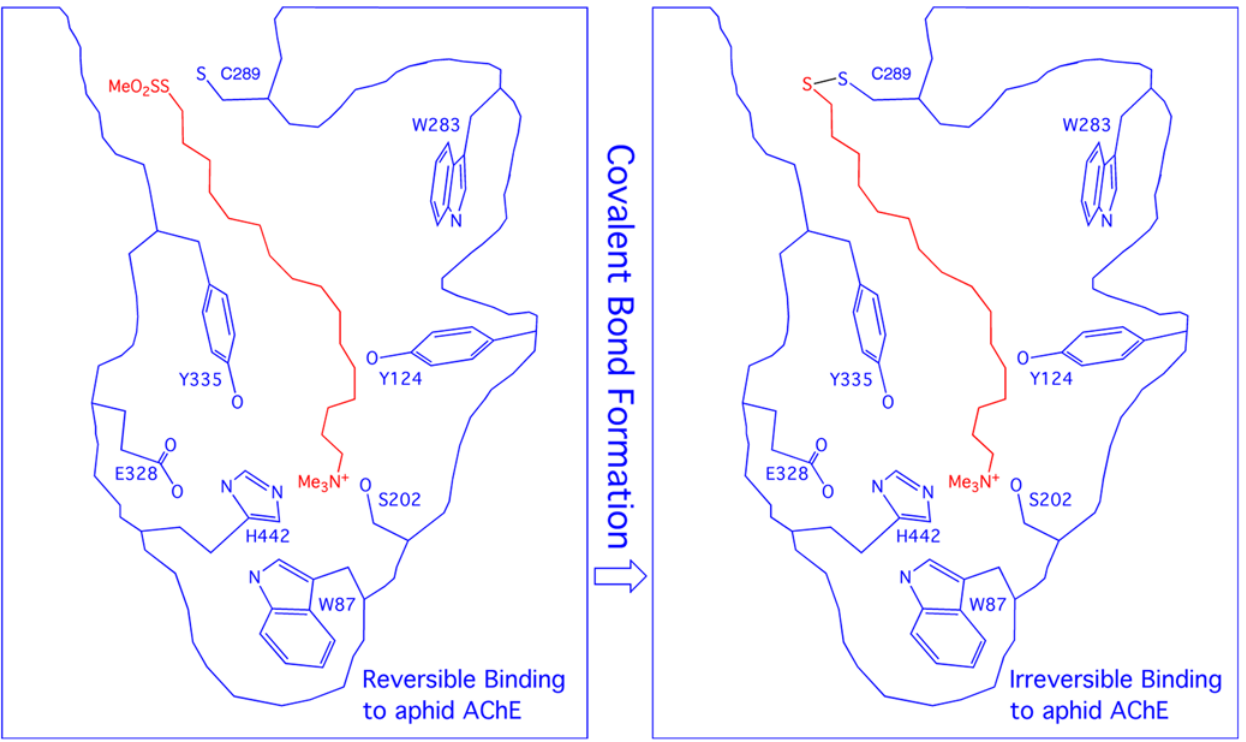
Figure 2. Diagram representation of a methanethiosulfonate-bearing inhibitor ( red ) that reacts with Cys289 of the greenbug acetylcholinesterase ( blue ) upon its binding at the active site.